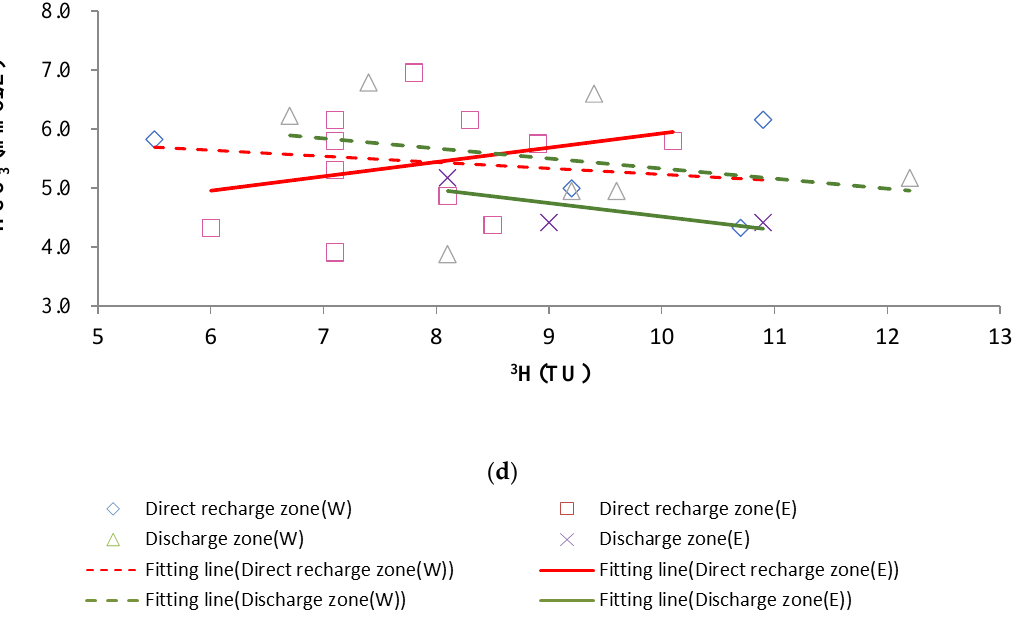
Figure 9. Correlation between the concentration of 3 H and major carbonate rock-related ions in karst water. ( a ) Correlation between the concentration of 3 H and Ca 2+ ; ( b ) Correlation between the concentration of 3 H and Mg 2+ ; ( c ) Correlation between the concentration of 3 H and the ratio of Ca 2+ and Mg 2+ ; ( d ) Correlation between the concentration of 3 H and HCO 3 − .